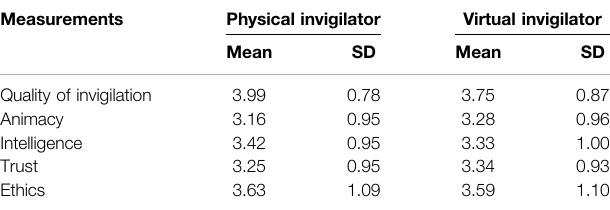
TABLE 2 | Measurements of study one: mean and